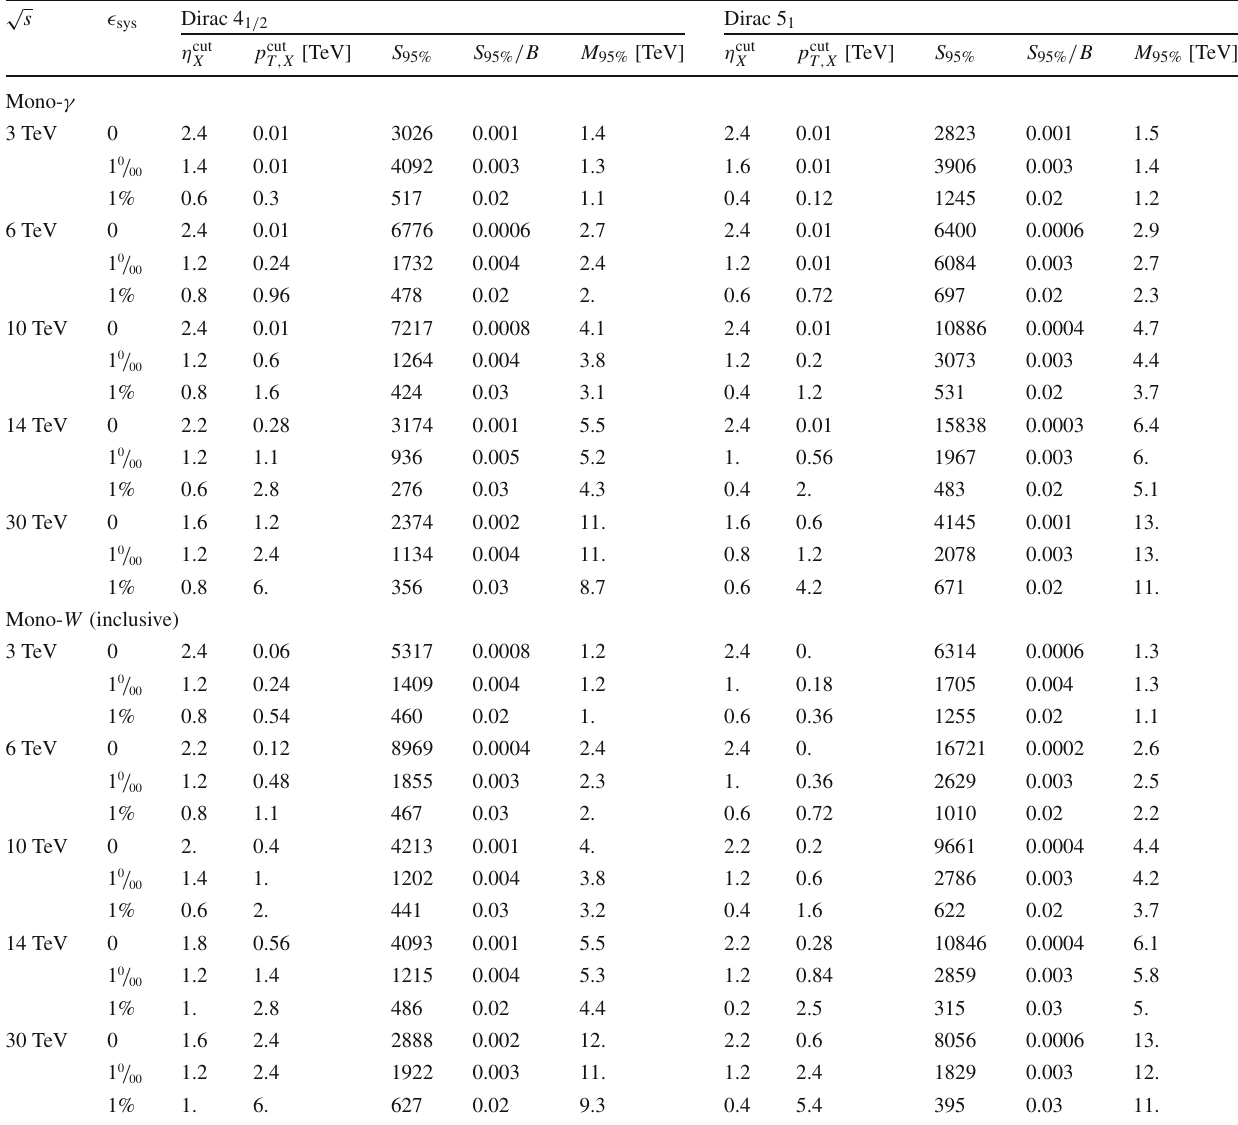
Table 4 95% CL reach on the mass of the Dirac 4 1 / 2 and 5 1 from the various mono-X channels. The excluded number of signal events S 95% and the relative precision S 95% / B are also given,together with the